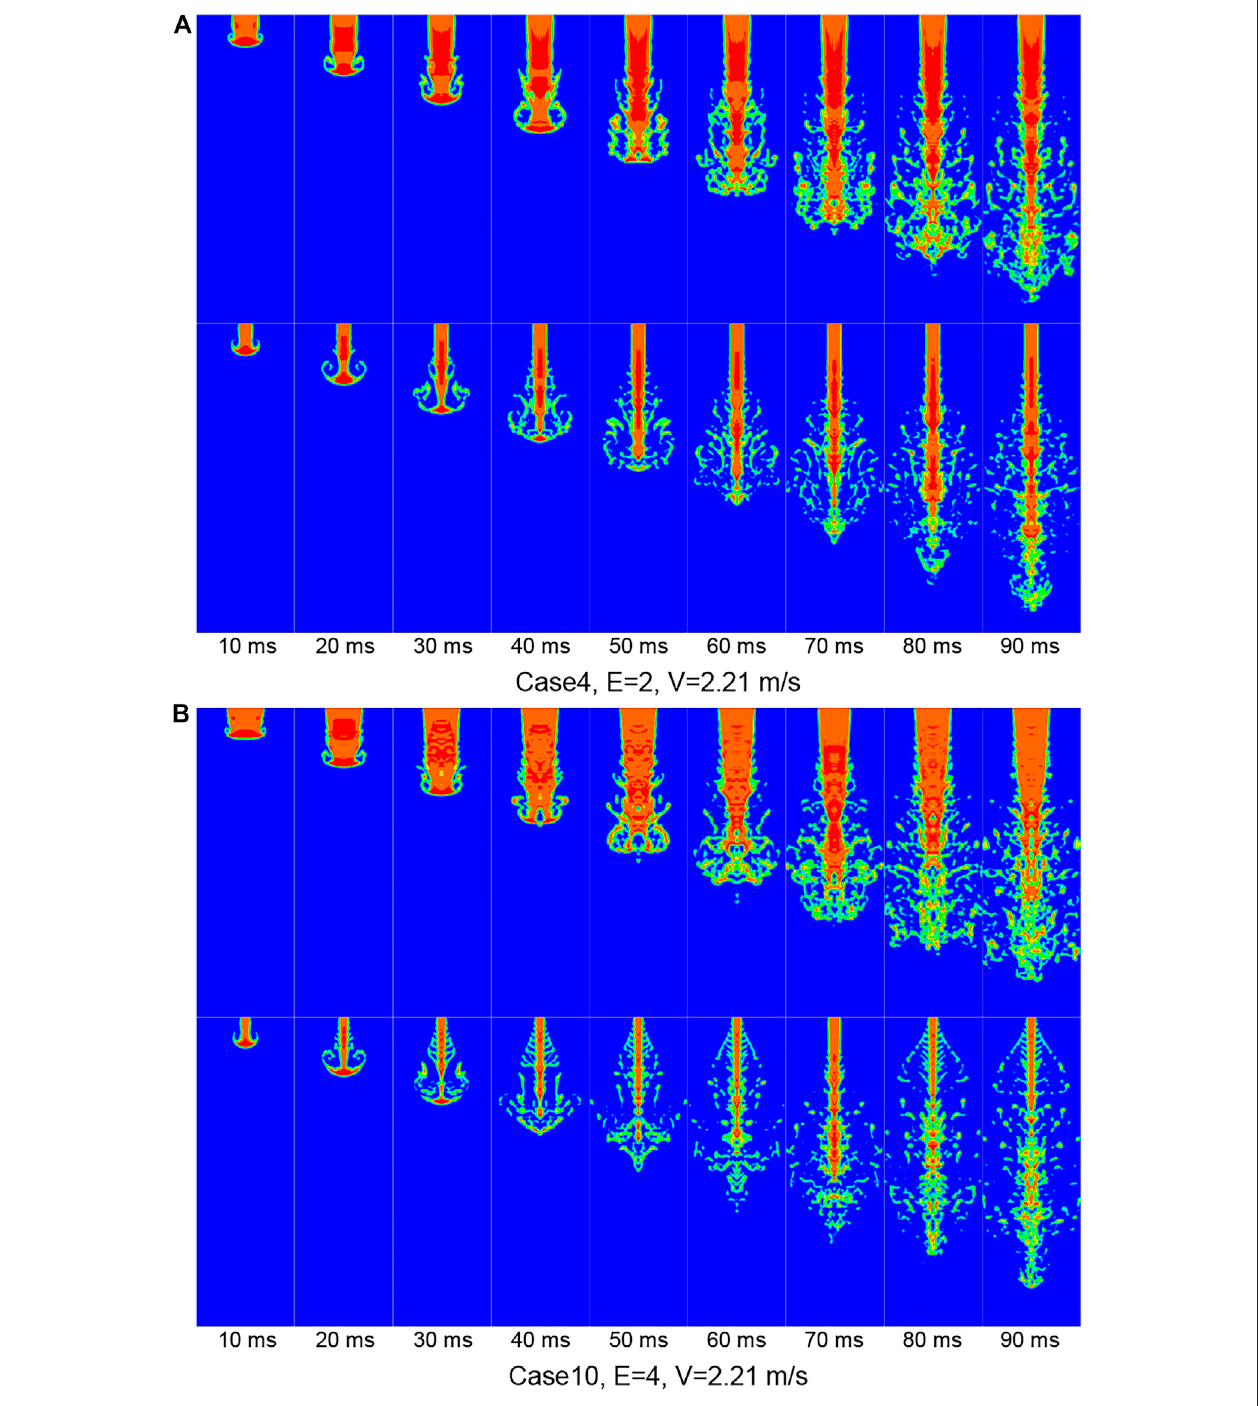
FIGURE 4 | Middle cross-sectional density contours along both major axis direction and minor axis direction.